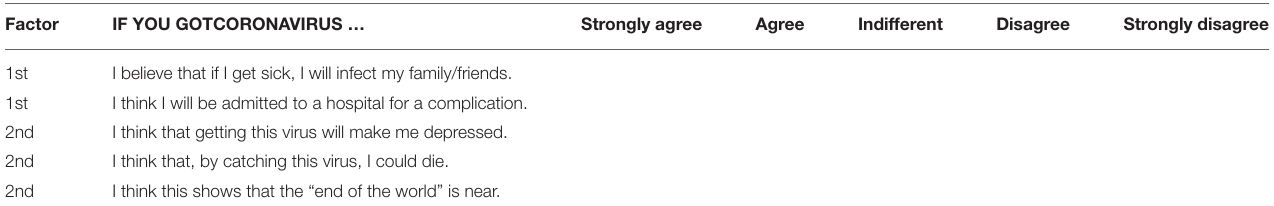
TABLE 3 | Final FAT-LAT-COVID-19, shortened version.